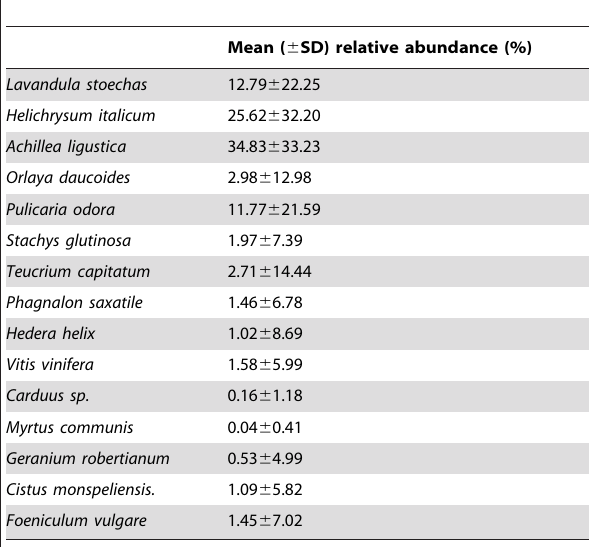
Table 4. Mean ( 6 SD) relative abundances of fifteen plant species identified from blue tit